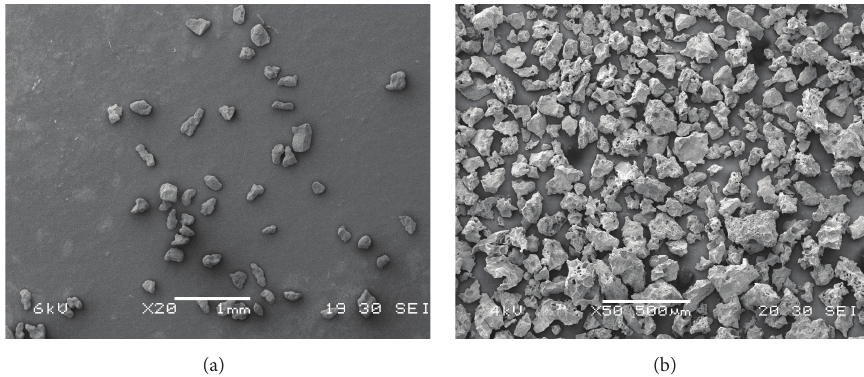
Figure 1: Scanning electron microscopy depicting the surface of (a) Cristobalite and (b) SCPC10 particles.